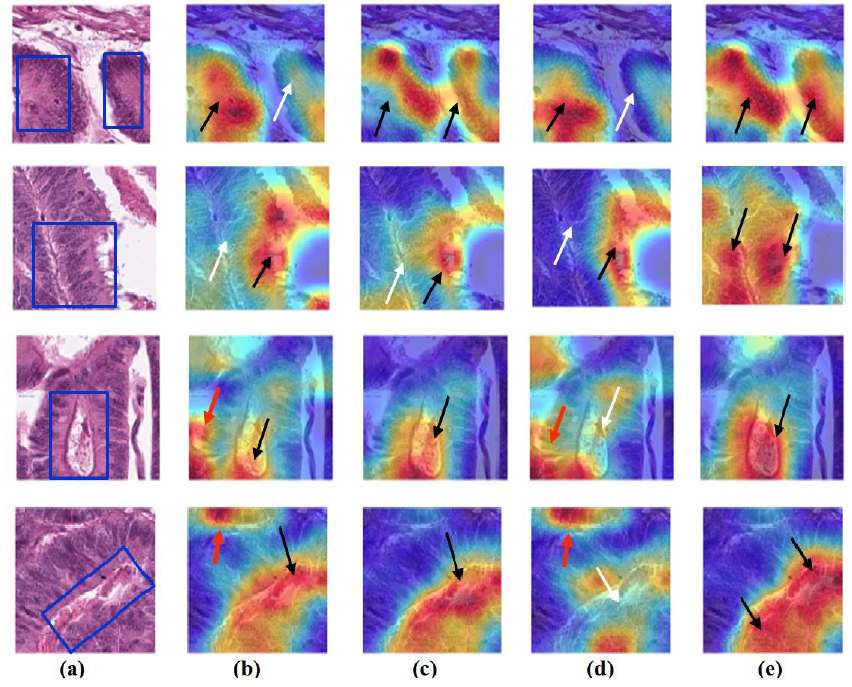
Figure 15. Visualisation of deep features for class TUM of CRC test set images obtained by each